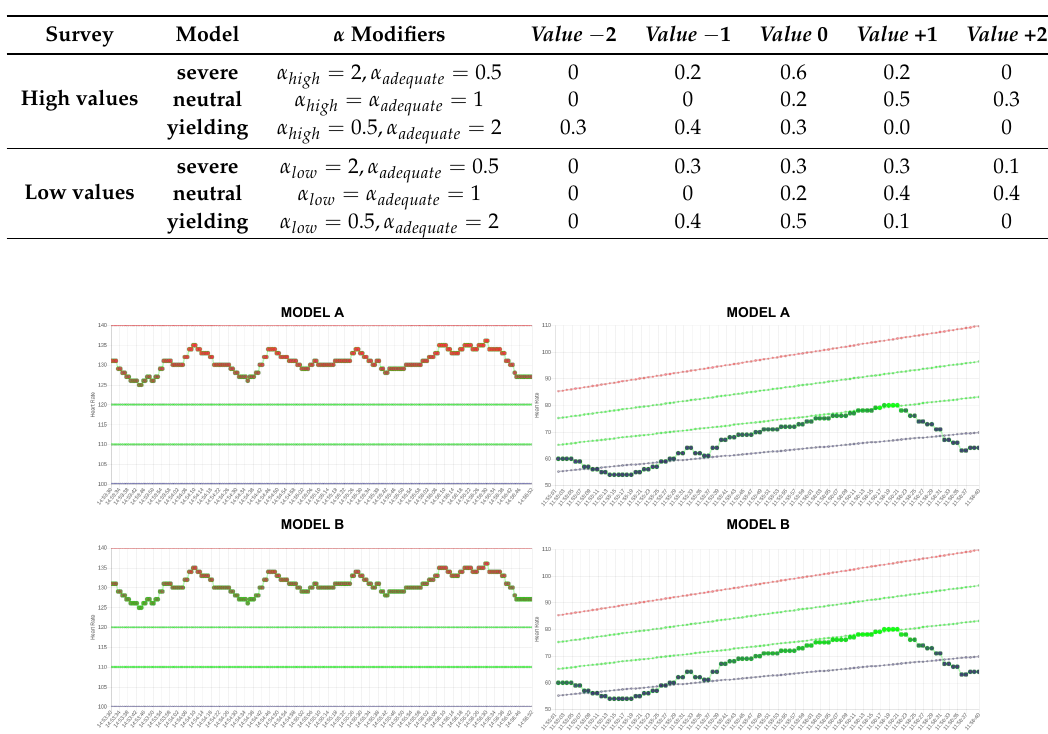
Table 1. The columns are related in order of: (1) survey; (2) model; (3) modifiers; and then percentages of responses for (4) value − 2; (5) value − 1; (6) value 0; (7) value +1; and (8) value +2.